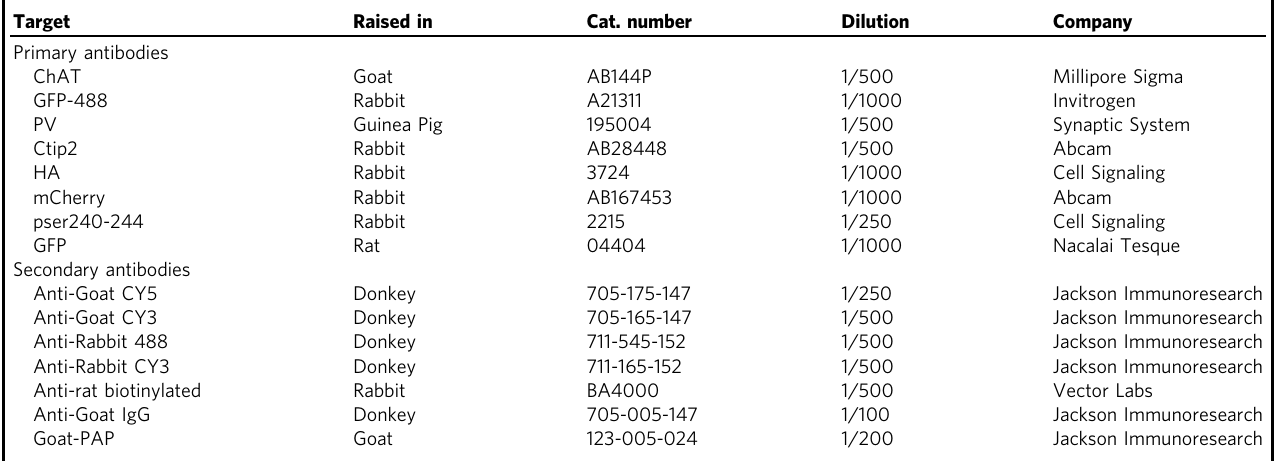
Table 3 Antibodies